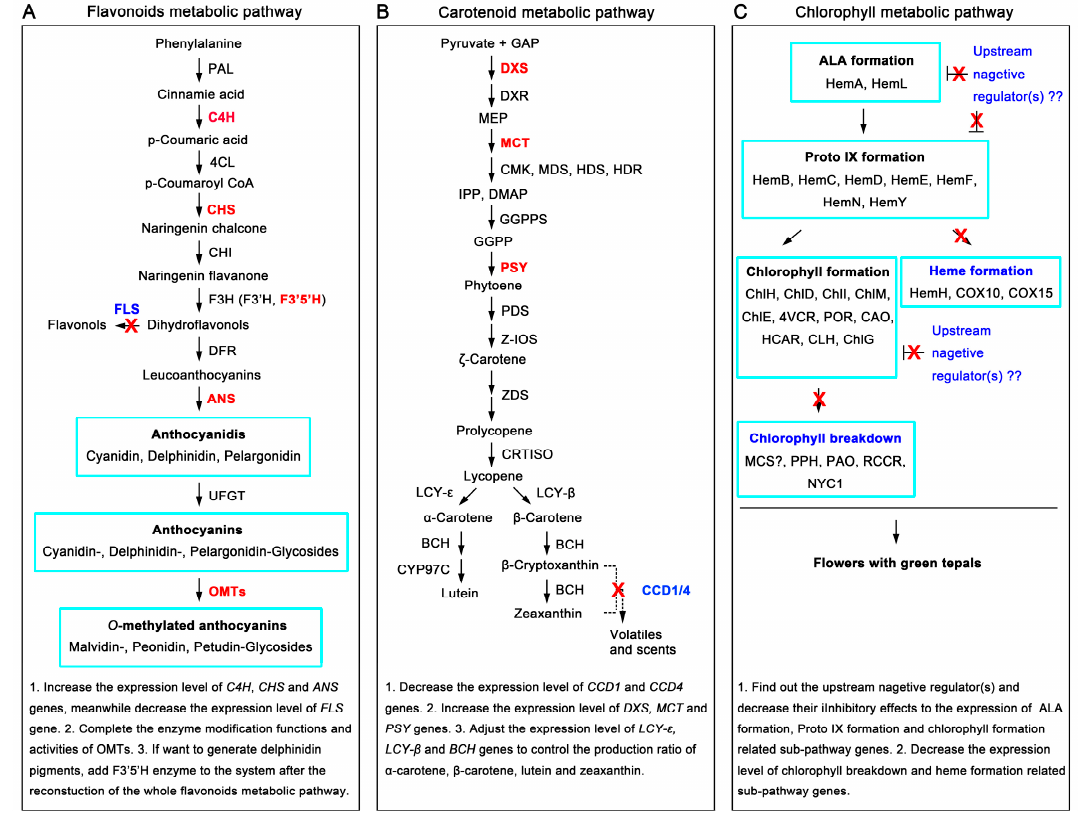
Figure 10. Proposed modification strategies of flavonoids, carotenoids and chlorophyll metabolic pathways in tepals of Chinese narcissus to acquire functional color pigments. ( A ) Reconstruction of flavonoids metabolic pathway to acquire functional anthocyanin pigments (cyanidin, delphinidin, and pelargonodin); ( B ) Modification of expression of some critical genes in carotenoids metabolic pathway to acquire sufficient functional carotenoids pigments; ( C ) Restriction of gene expression in chlorophyll breakdown and heme formation sub-pathways meanwhile increase gene expression in ALA formation, Proto IX formation and chlorophyll formation sub-pathways may produce flower with green tepal. The specific suggestions for modifications of each pathway are listed at the bottom of each section. Black filled arrows indicate the substance metabolism directions; red “X” means the decrease or deletion of the expression of negative gene(s) or sub-pathways in order to remodel the main pathway.